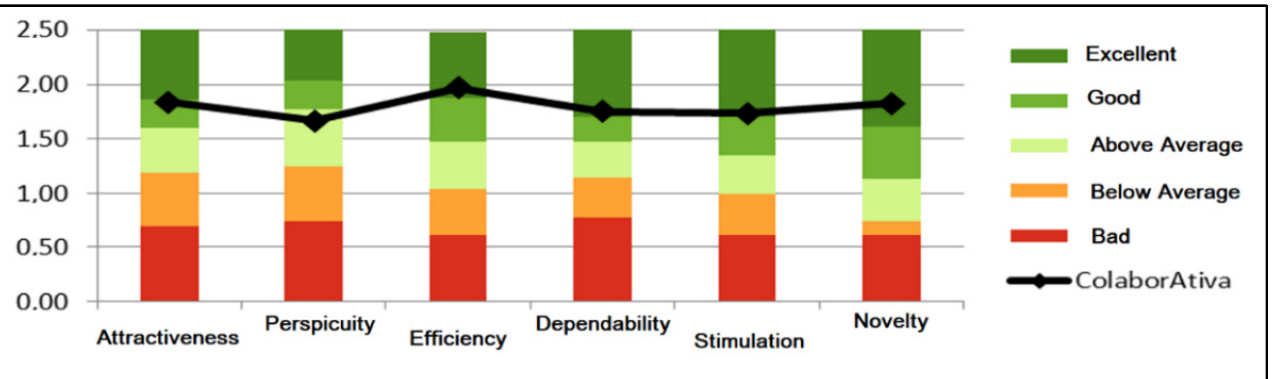
Figure 6. Answers’ distribution graphic generated by data analysis tool provided by UEQ grouped by scales [28].